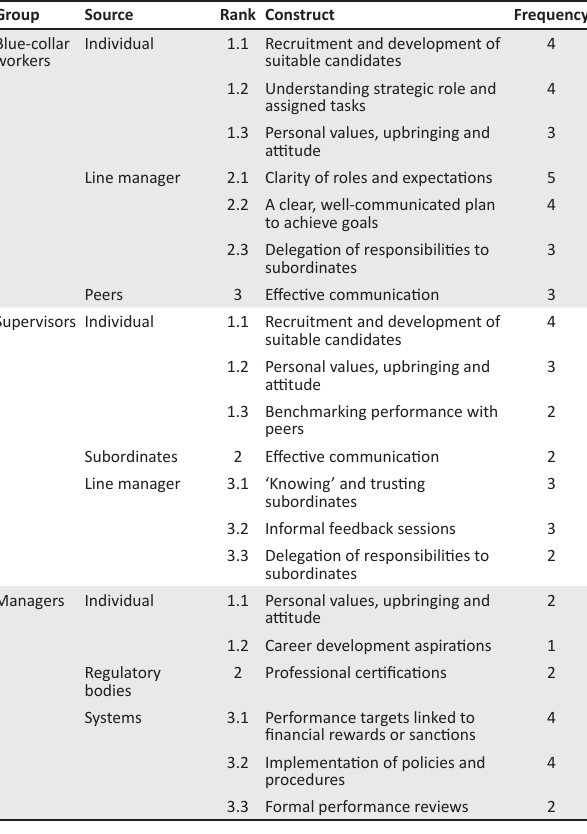
TABLE 7: Accountability mechanisms introduced by identified sources. Group Source